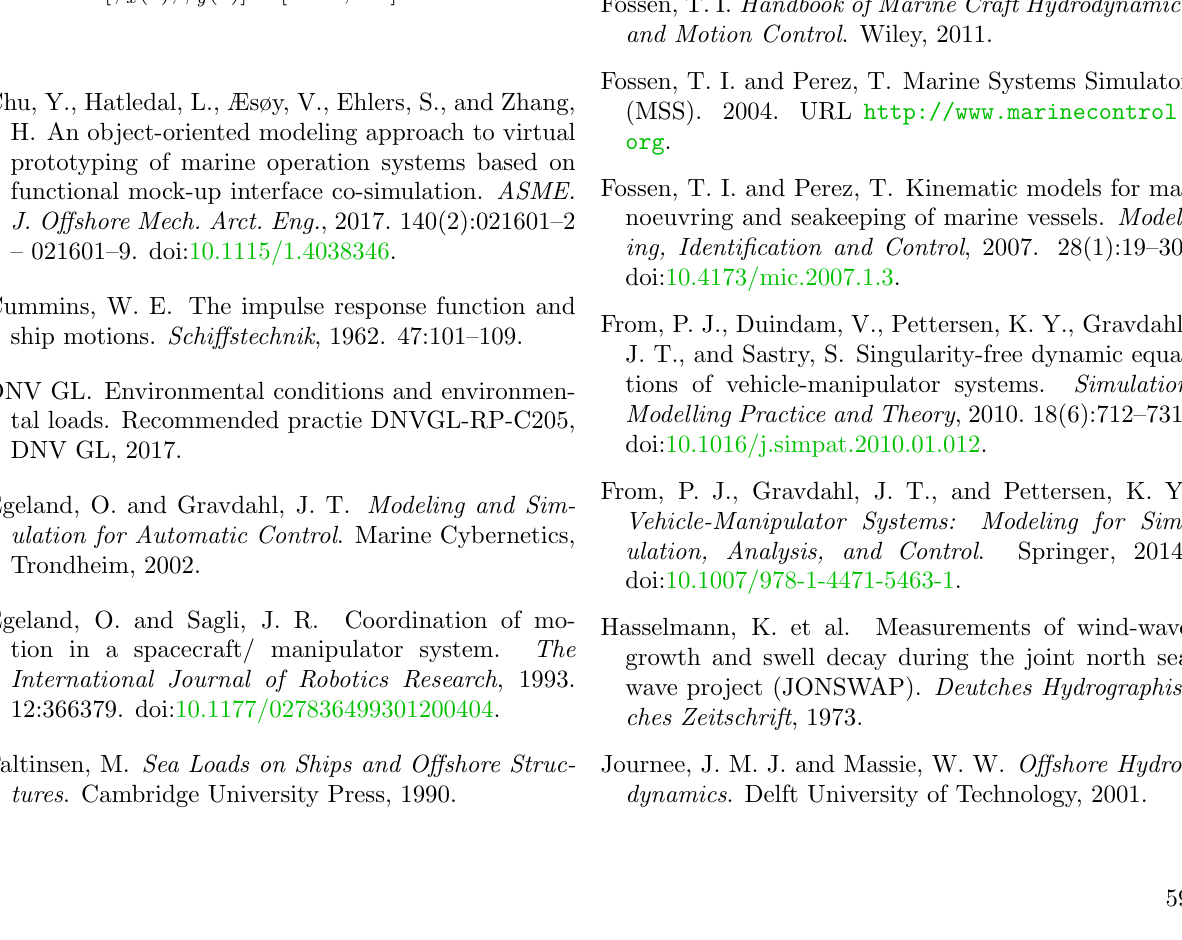
Figure 10: x , y and z coordinates of the crane tip rela- tive to and expressed in coordinates of iner- tia frame { n } . The desired crane tip is kept stationary relative to and expressed in { n } . The blue graph is the crane tip position due to orientations [ φ x , φ y ] of the pendu- lum with initial conditions [ φ x (0) , φ y (0)] ≈ [0 ◦ , 0 ◦ ]. The red graph is the crane tip position due to orientations [ φ x , φ y ] of the swinging pendulum with initial conditions